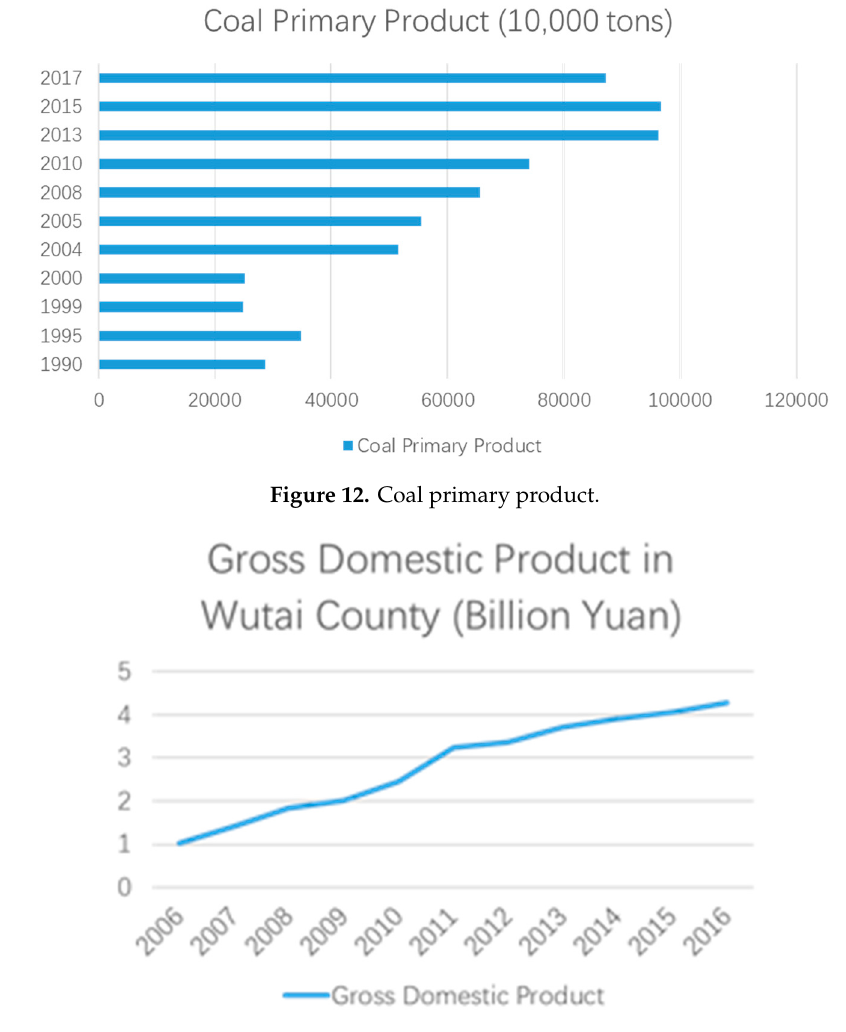
Figure 13. GDP in Wutai county.